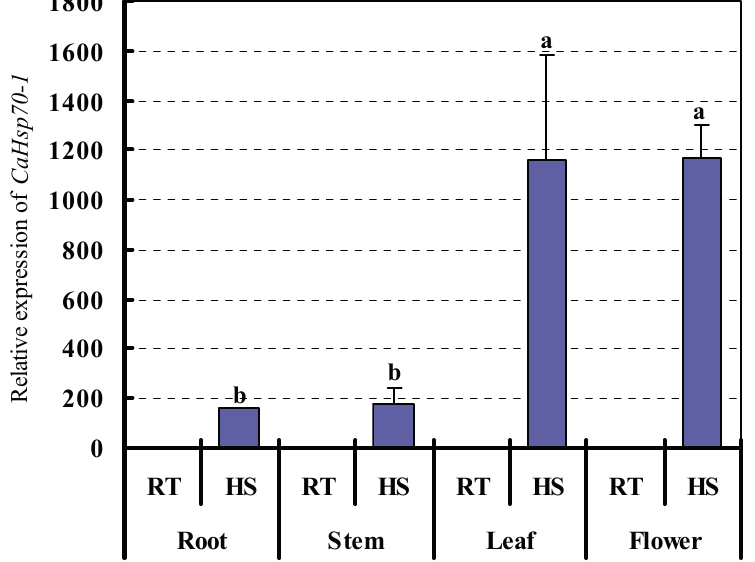
Figure 4. Expression of CaHsp70-1 in R9 tissues. R9, pepper thermotolerant line; RT, room temperature (26 °C for 2 h); HS, heat stress (40 °C for 2 h). Expression data were normalized with UBI-3 as reference gene. The expression levels are relative to that of the leaf from R9 under RT. Error bars indicate the mean and standard deviation ( n = 3), and the different lowercase letters show the significant difference at α = 0.05